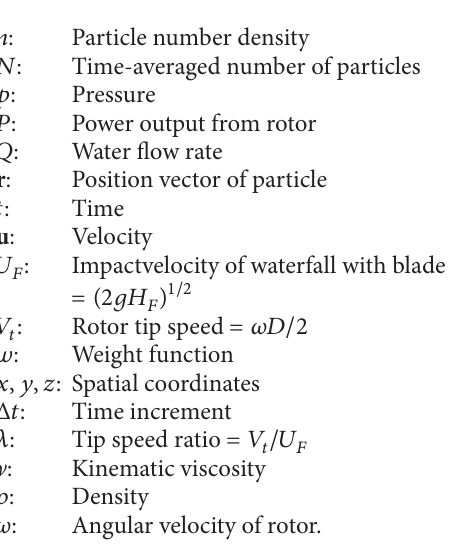
also analyzed by using the simulated flow field. The results are summarized as